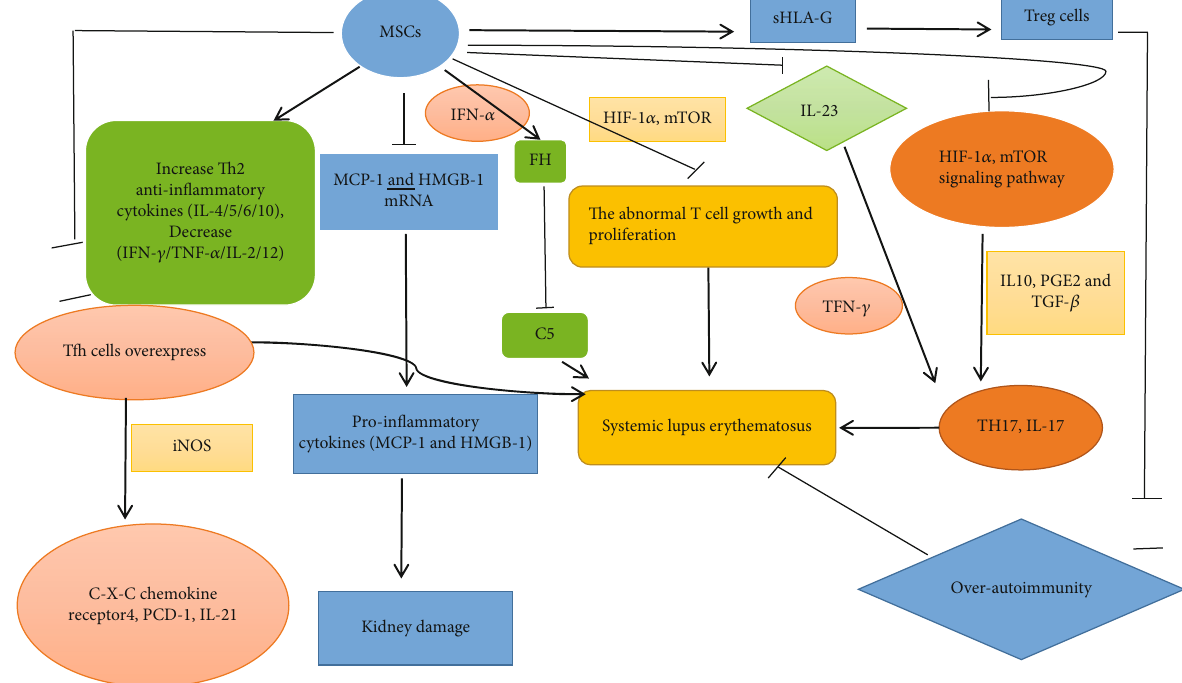
Figure 1: E ff ect of MSCs on cytokine production in systemic lupus